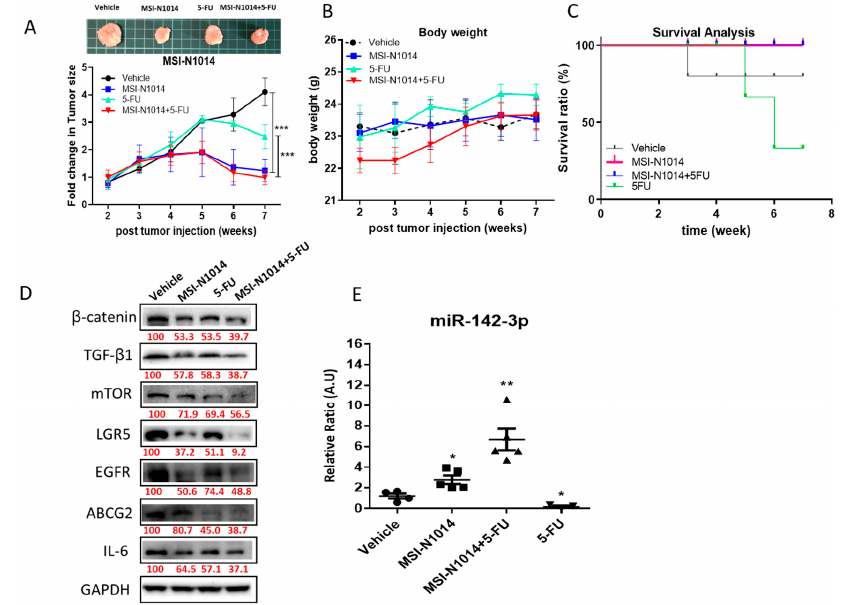
Figure 5. E ffi cacy evaluation of MSN-N1014 using a cancer-associated fibroblast (CAF)-educated DLD1 xenograft mouse model. ( A ) Tumor size over time curve. The tumor growth delay was most significant in the MSI-N1014 + 5-fluorouracil (5-FU) treatment group, followed by the MSI-N1014-only group, while the 5-FU-only and vehicle control groups did not show a significant di ff erence. The insert shows representative photographs of tumor samples from each group. ( B ) Average body weight over time curve. No significant di ff erences were observed among the di ff erent groups. ( C ) Kaplan-Meier survival curve. Mice receiving MSI-N1014 only and the combination MSI-N1014 + 5-FU regimen showed the highest survival ratios, while 5-FU-only and vehicle mice showed the lowest survival ratios. ( D ) Tumor sample Western blot analysis. Expressions of key molecules associated with oncogenic (epidermal growth factor receptor (EGFR) and mammalian target of rapamycin (mTOR)), stemness-associated (leucine-rich repeat-containing G-protein coupled receptor 5 (LGR5) and β -catenin), drug resistance (ATP-binding cassette super-family G member 2 (ABCG2)), and inflammatory cytokines (transforming growth factor (TGF)- β 1 and interleukin (IL)-6) were clearly lower in samples from MSI-N1014 + 5-FU and MSI-N1014-treated tumors. ( E ) qPCR analyses of plasma levels of miR-142-3p. Pooled blood samples from all four groups of mice were analyzed for miR-142-3p plasma levels. The combination group showed the highest level followed by NSI-N1014 alone. Numbers in red indicate the relative expression ratio. * p < 0.05; ** p <